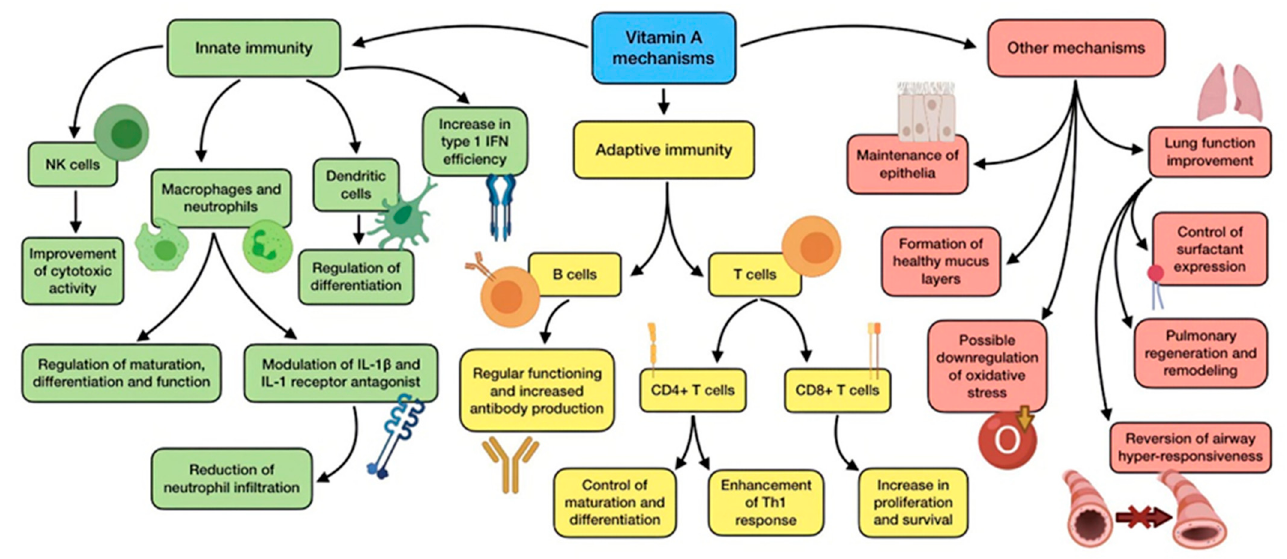
Figure 4. Summary of the main vitamin A mechanisms of action.